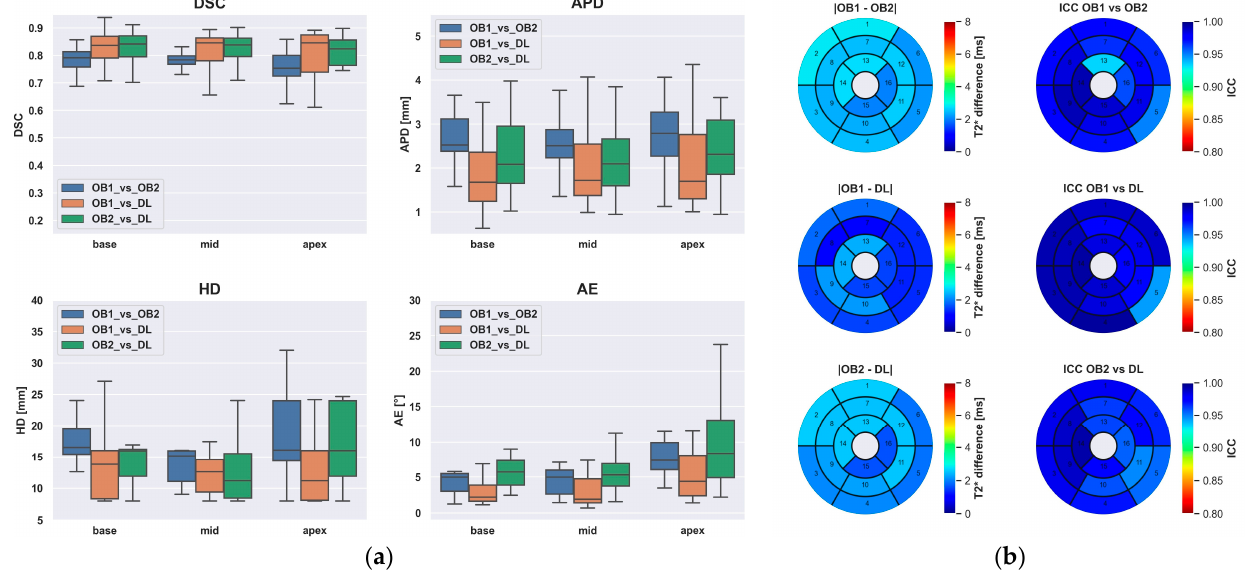
Figure 4. Inter-observer variability of the two experts compared to the fully-automated method. ( a ) Boxplot of the segmentation metrics. ( b ) Bull’s-eye plots showing the regional distribution of segmental T2* differences according to the AHA model (left panels) and ICC between observers and the DL-based method (right panels).